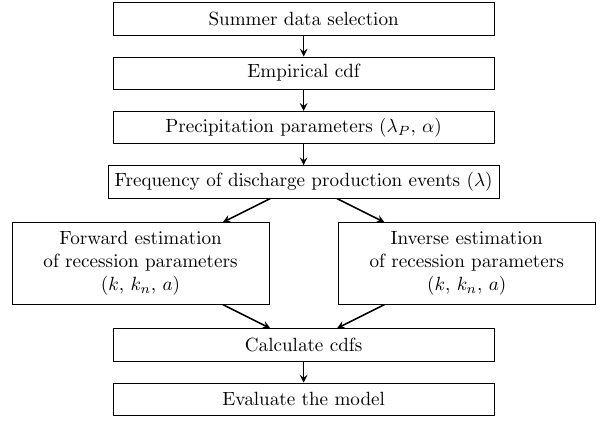
Figure 1. Sketch of the adopted workflow for model parameter es- timation and performance